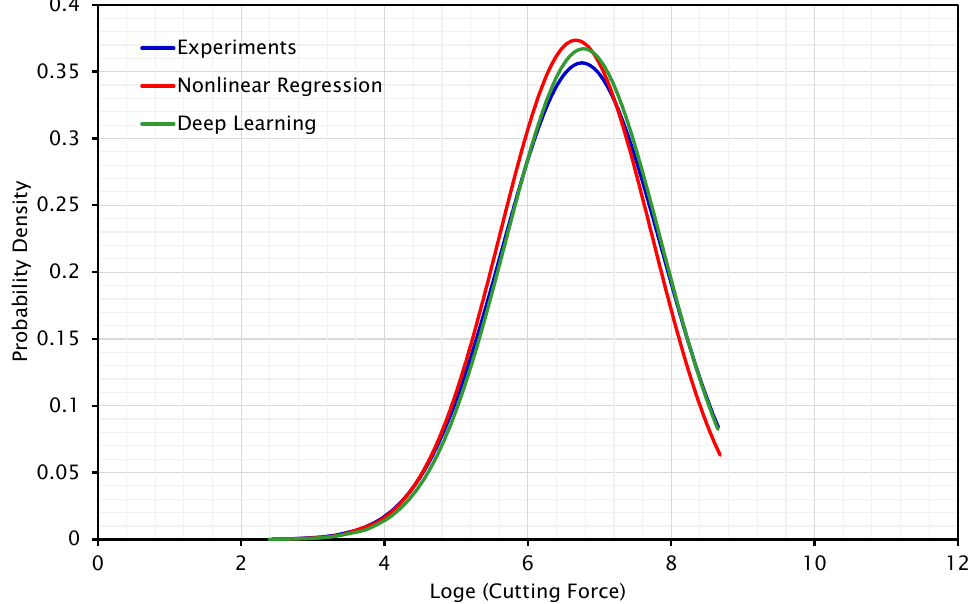
Figure 14. Normal distribution of cutting force concluded from experimental data and the results of regression by non-linear regression and deep learning